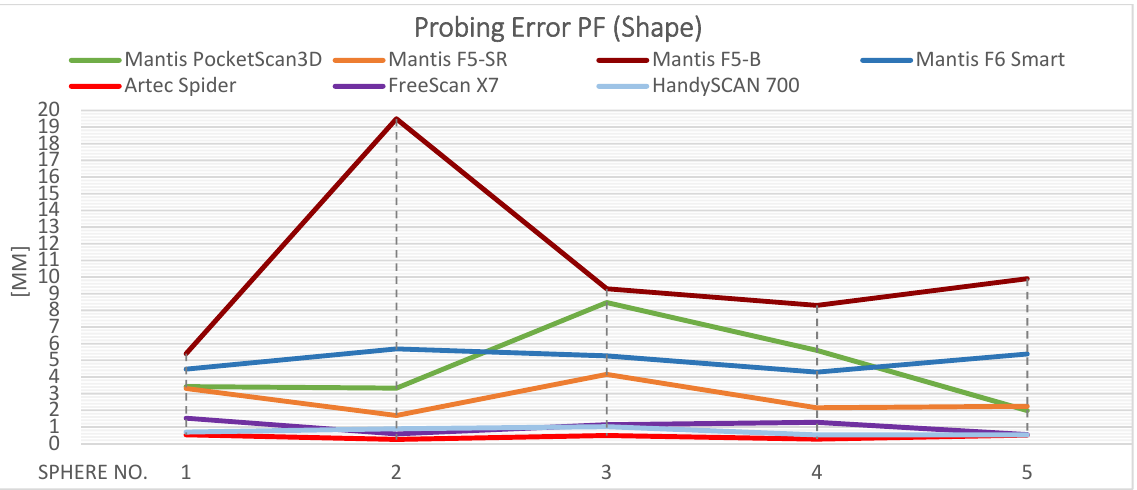
Figure 3. Results of the quality parameter probing error shape (PF) equivalent to VDI/VDE 2634, part 2